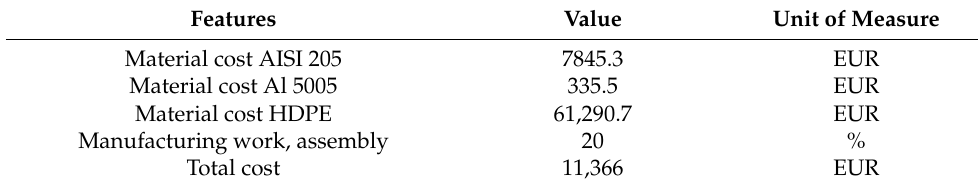
Table 12 summarises these items: the total cost of the complete platform is EUR 11,366. Table 12. Overall cost of a single floating platform. Features